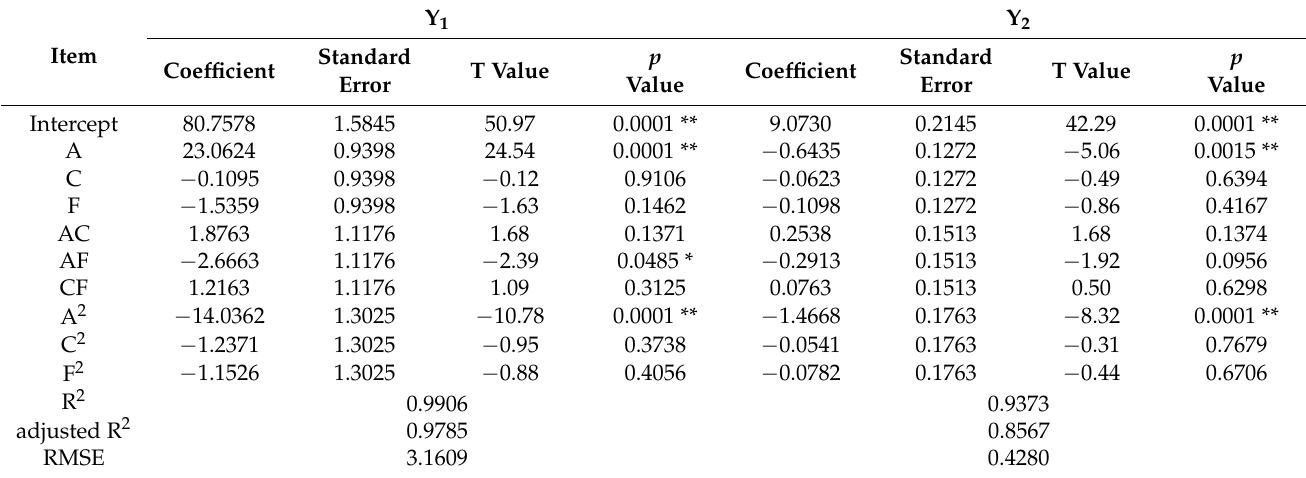
Table 2. Analysis of the significant parameters in the CCD test.